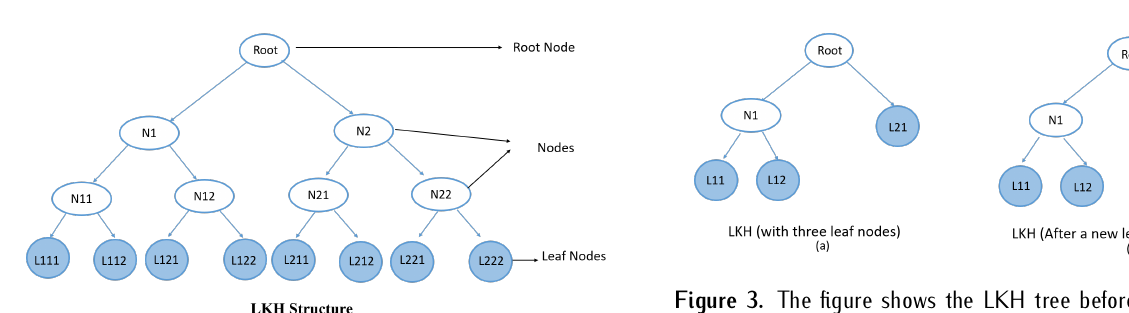
Figure 3. The figure shows the LKH tree before and after node L22 joins the group.